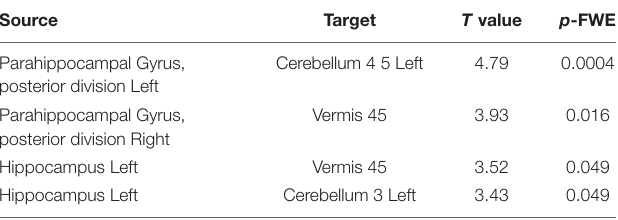
All altered connections are users > non-users. Statistics shown are FWE corrected at the seed level. R, right; L, left; Cerebellum 45, Cerebellar lobules IV/V; Vermis